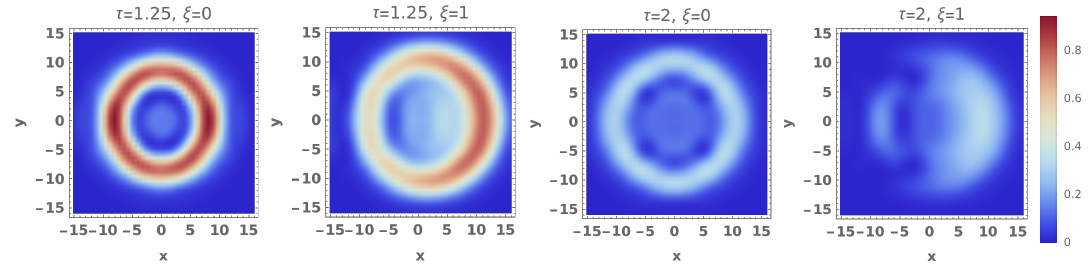
Figure 4 . The hydrodynamic residual ∆ at zeroth order in transverse derivatives, for proper times τ = 1 . 25 , τ = 2 and rapidities ξ = 0 , ξ = 1 . Already at zeroth order the residual ∆ (0) agrees well with the exact results. As in [3] we find a hydrodynamization time of about t ≈ 1 . 25 for the central region.